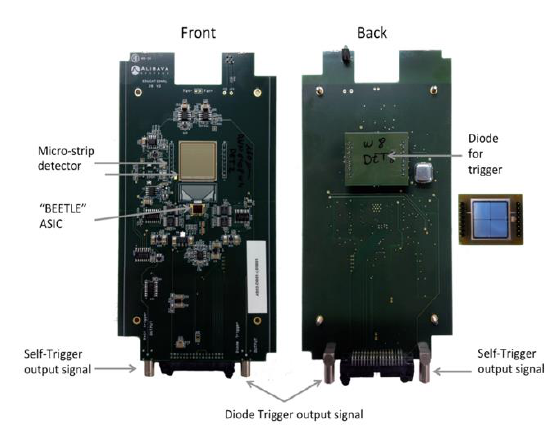
Fig . 2. Sensor Unit holding the micro-strip detector and the BEETLE in the front side and the Diode for trigger proposes in the back. The Board have two connectors for the trigger signal: Diode Trigger and Self-Trigger.